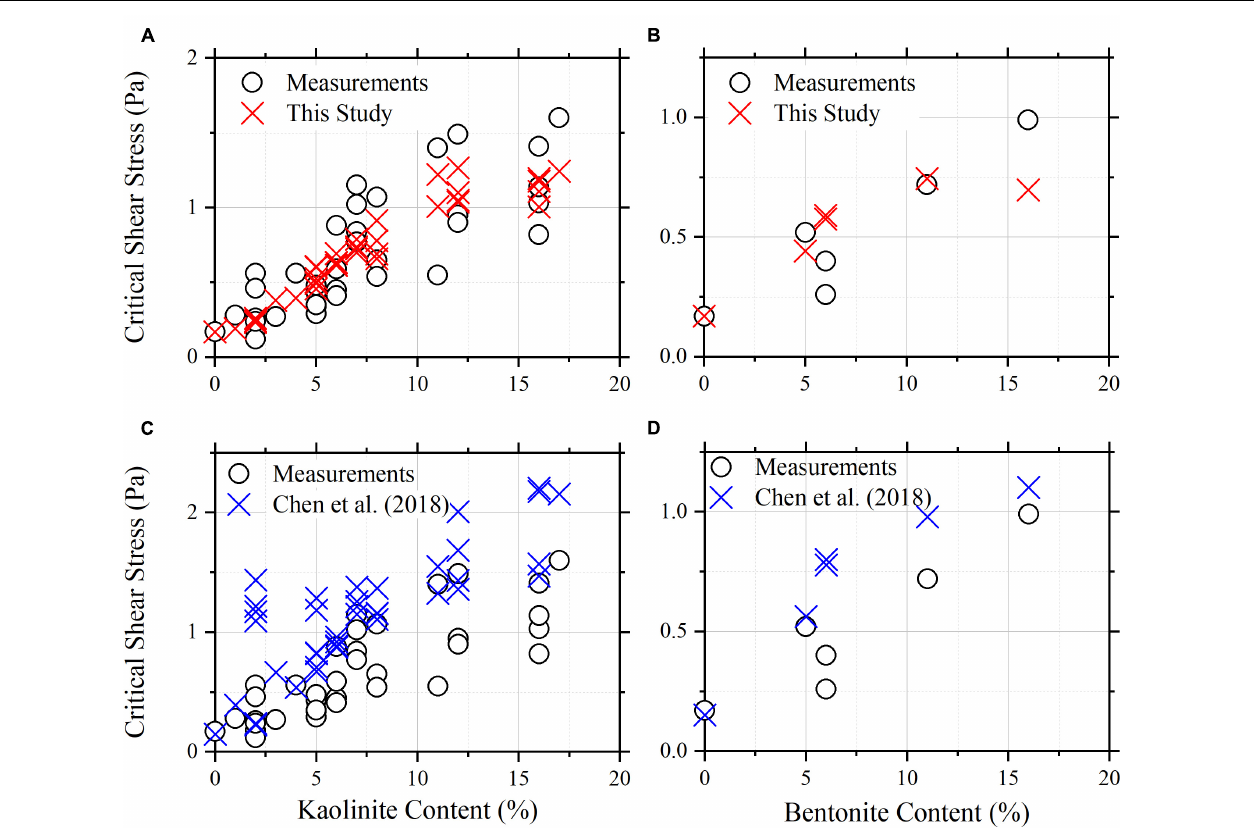
FIGURE 6 | The calculated vs. measured critical shear stresses in the case of Jacobs et al. (2011): (A,C) sand-silt-kaolinite mixtures, (B,D) sand-silt-bentonite mixtures; (A,B) Eq. (23) and (C,D) the formula of Chen et al. (2018).